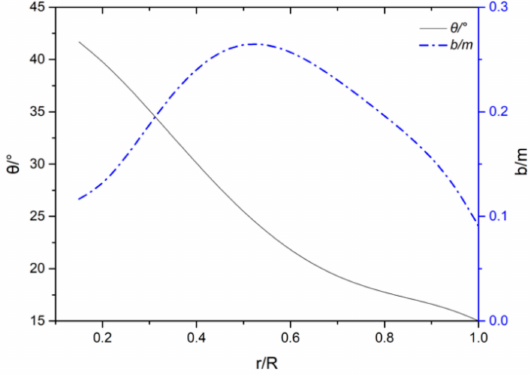
Figure 12. Shape parameters of the